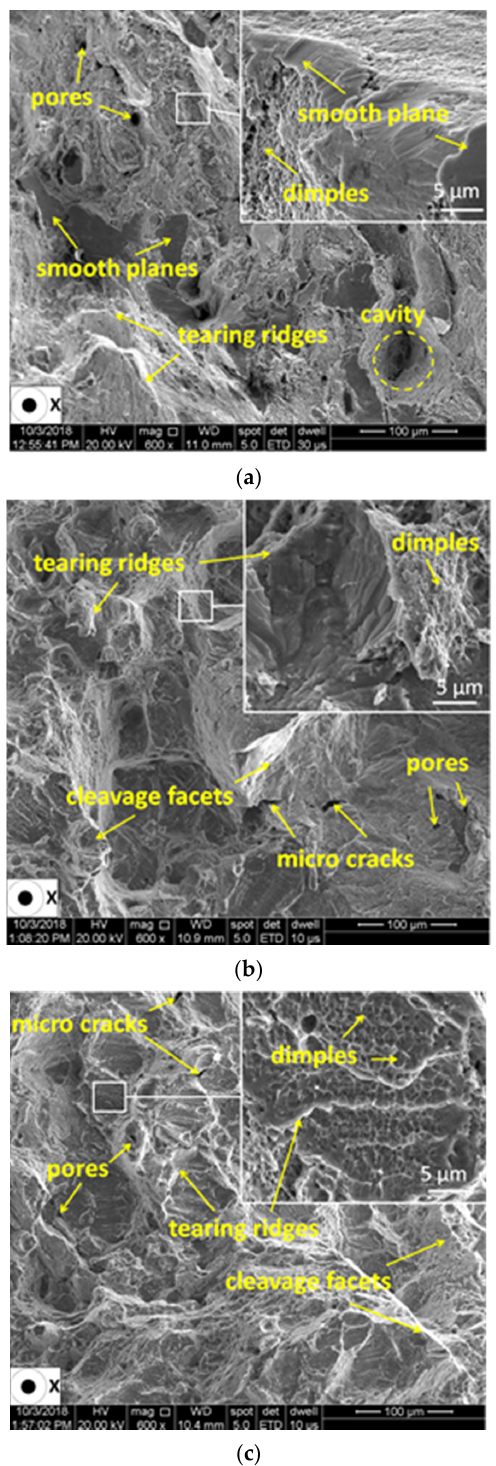
Figure 17. Fractographs of smooth ( a ) and V-notched test pieces. With root radii 0.05 mm ( b ) and 0.63 mm ( c ) tested in as-built state.